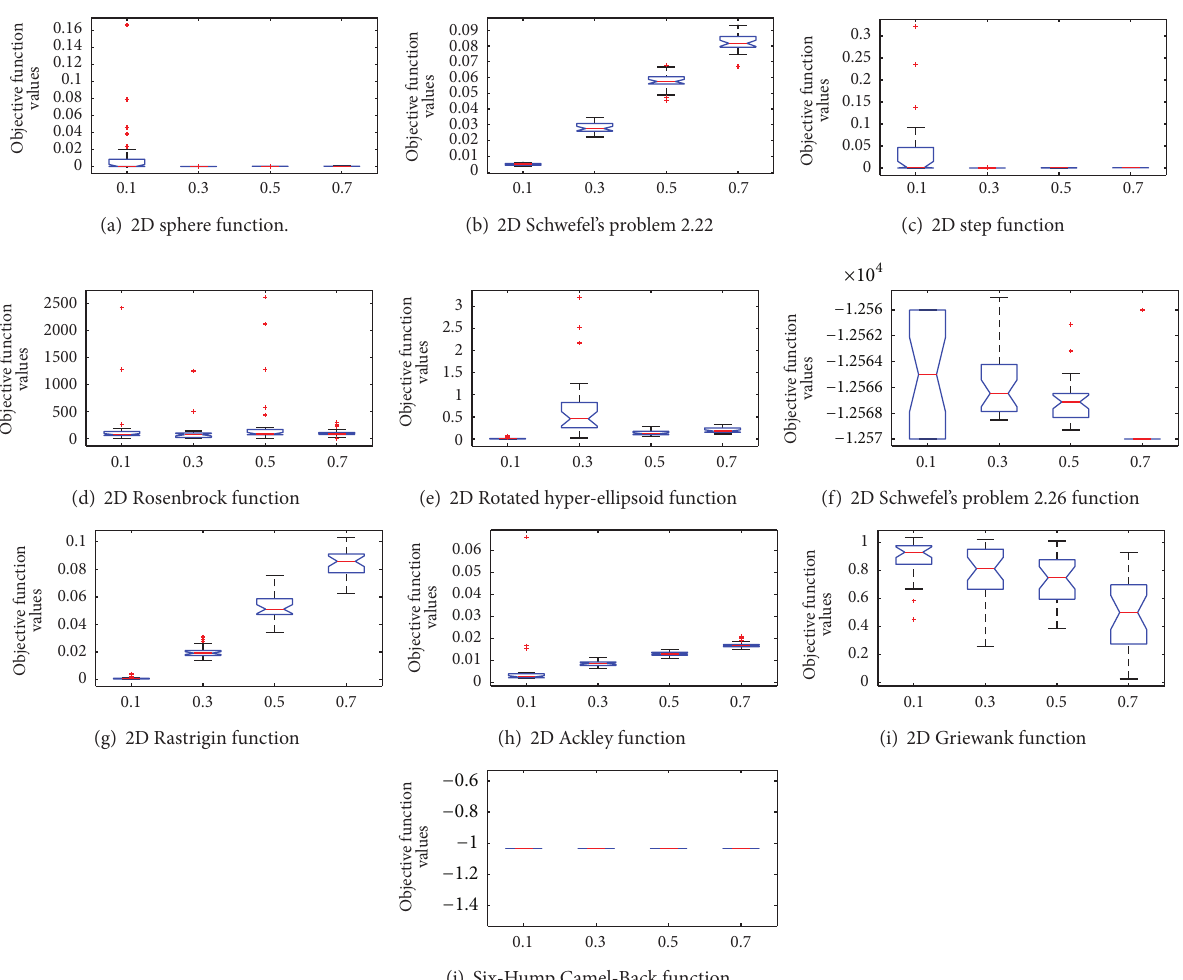
Figure 10: The box plots for showing the effect varying PAR values using the ten global optimization